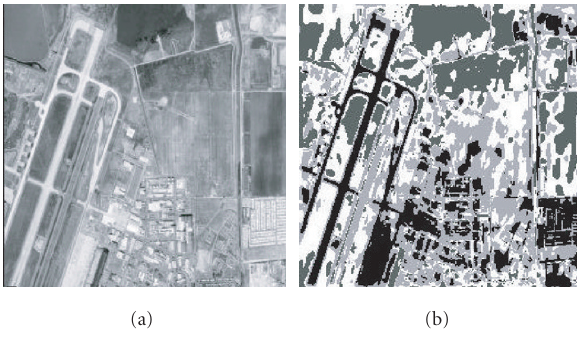
Figure 10: SPOT5 image segmentation given K =